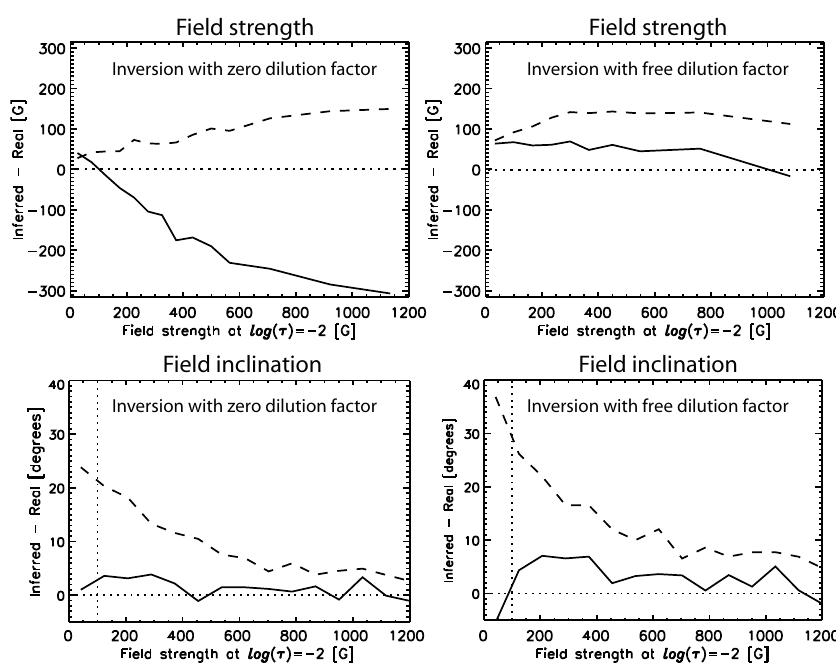
Fig. 9 Errors and uncertainties in the field strengths (top) and field inclinations (bottom) inferred from one-component ME inversions of simulated Hinode/SP observations. The error (solid lines) represents the difference between the inferred parameters and the MHD model at log τ 500 = − 2. We show mean errors averaged over all the pixels with sufficient polarization signal (Stokes Q , U , or V amplitudes larger than 4.5 times the noise level of 10 − 3 I QS ). The uncertainties (dashed lines) are the standard deviation of the individual errors. Both errors and uncertainties are plotted as a function of field strength. The panels on the left correspond to inversions assuming α d = 0, while those on the right correspond to inversions in which the dilution factor is left as a free parameter, in order to account for the effects of telescope diffraction. ReproducedwithpermissionfromOrozcoSuárezetal.(2007a)andOrozcoSuárezandBellotRubio(2012), copyright by